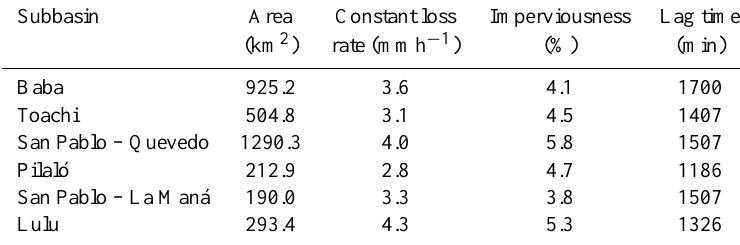
Table A1. Surface water variables for the Vinces River model in HEC-HMS.